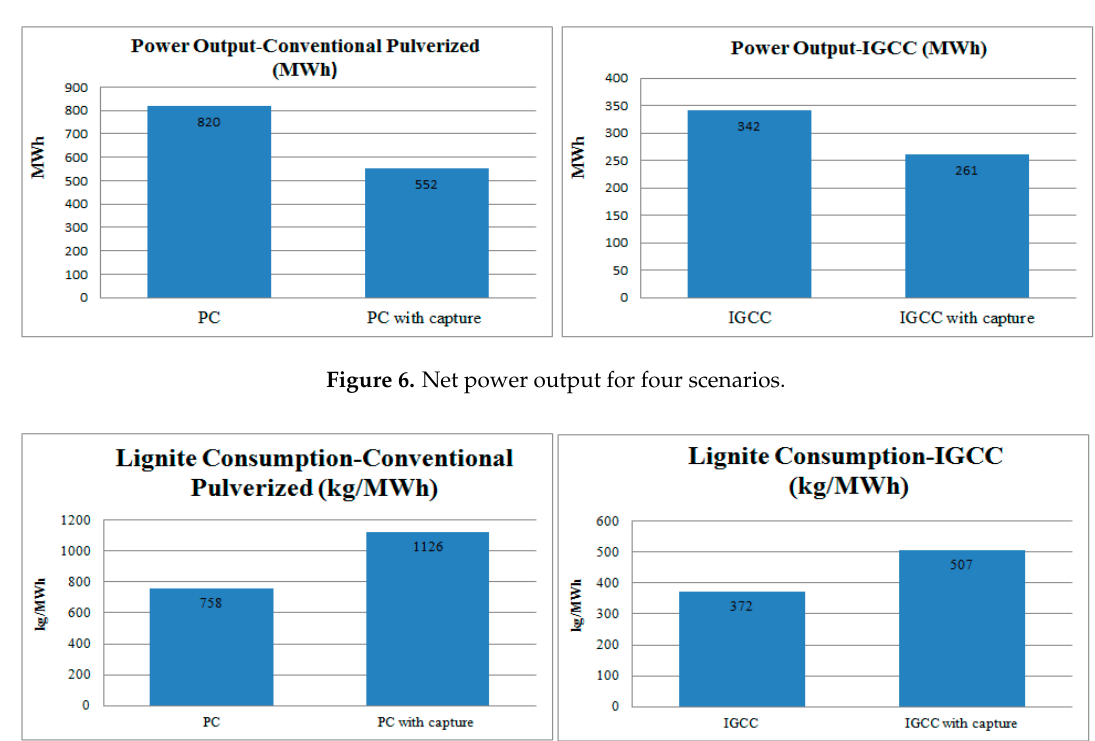
Figure 7. Lignite consumption for four scenarios.